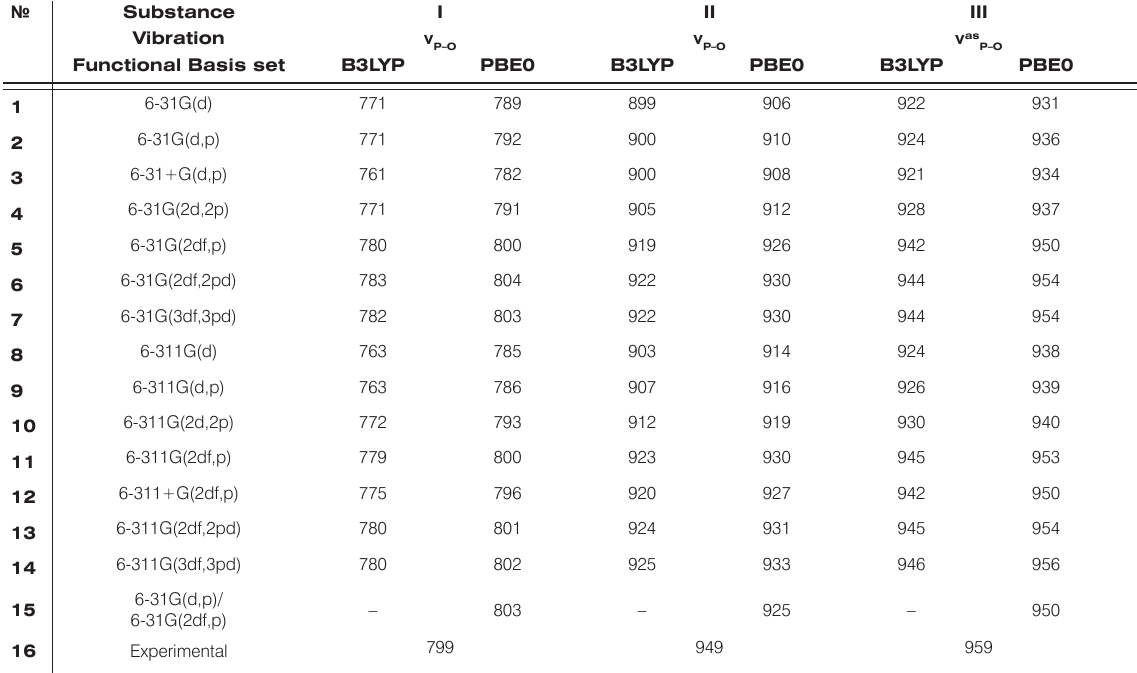
Table 6. Frequencies of P–O stretching vibration (cm -1 ).